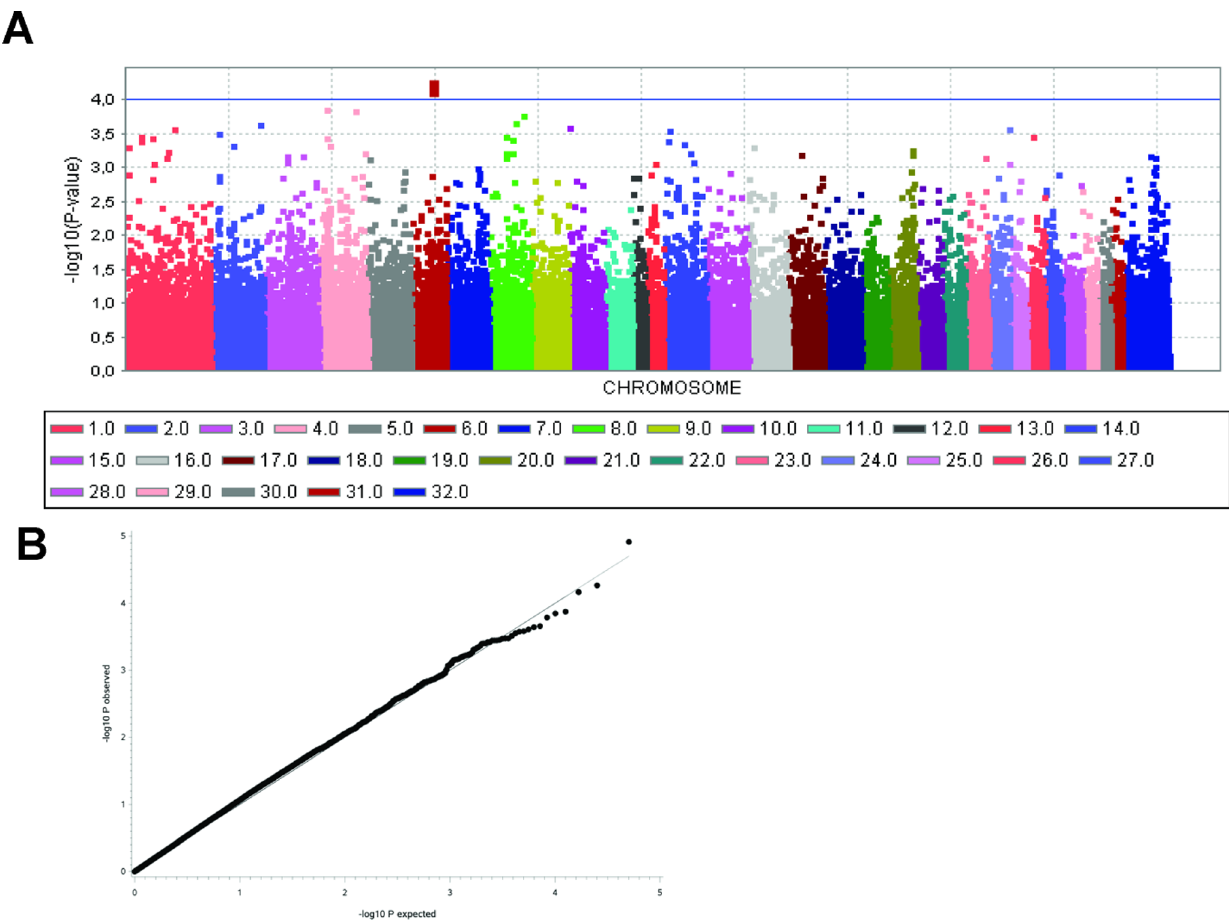
Figure 1. Manhattan plot of 2 log 10 P-values of the genome-wide association study for estimated breeding values of the paternal component of the pregnancy rate per estrus cycle (EBV-PAT) in Hanoverian stallions using a mixed linear model analysis (A) and Q- Q plots of observed versus expected 2 log 10 P-values (B) from the mixed linear model analysis for EBV-PAT. (A) On the X-axis, the SNPs are given by horse chromosome number. The 2 log 10 P-values for each SNP effect are plotted against the SNP position on each chromosome. Chromosomes are differentiated by colors. The color keys are given below the plot. The blue line indicates the threshold of the 2 log 10 P-values . 4.0. The peak value (BIEC2-952439) is located on horse chromosome 6 at 45.556 Mb. (B) The expected 2 log 10 P-values (solid line) are plotted against the observed 2 log 10 P-values (black dots). (Table 2). After accounting for multiple testing using a Bonferroni correction, two genotyped SNPs (g.45599001G . A, P Bonf = 0.047 and BIEC2-952439 (g.45586821C . T), P Bonf =0.047) and one